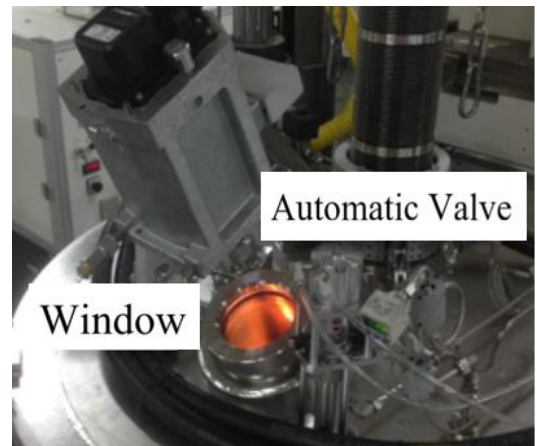
Figure 4. Crystal images acquisition device. Sensors 2018 , 18 , x FOR PEER REVIEW